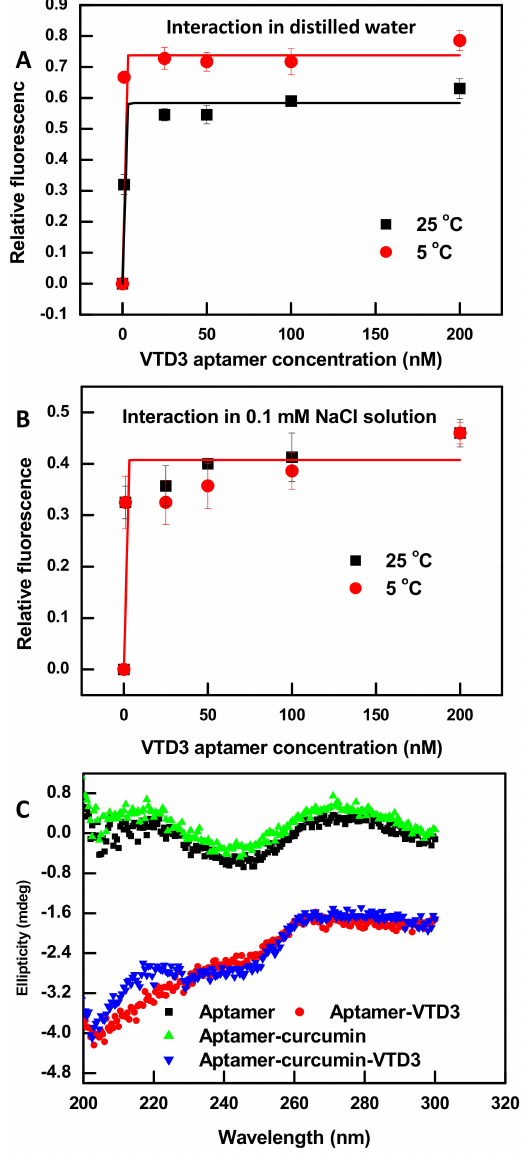
Figure 1. Fluorescence characterization of the interaction of curcumin molecule (0.6 µ M) with VTD3 aptamer in ( A ) deionized water and ( B ) 0.1 mM NaCl solution and the e ff ect of temperature on the degree of fluorescent enhancement. Error bars represent standard deviations from two measurements. Lines are non-linear fits of the data for K D measurements. ( C ) Circular dichroism (CD) measurements of di ff erent aptamer samples generated during the construction of the curcumin based sensor and detection of VTD3. The concentration of aptamer, curcumin, and VTD3 are 0.8 µ M, 0.6 µ M, and 20 µ M